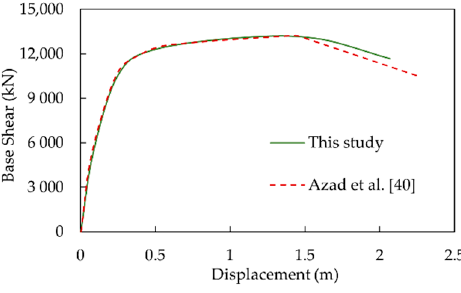
Figure 2. Pushover curve of the model.